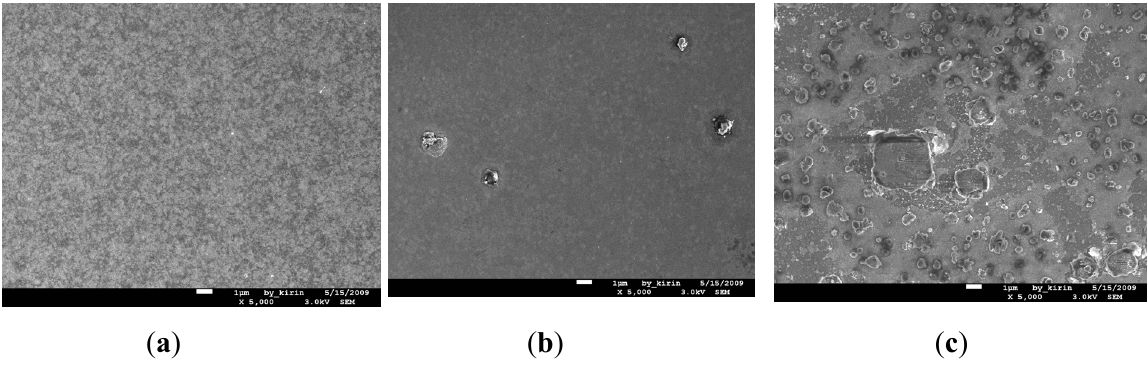
Figure 9. X-ray diffraction patterns for the structures of MgO (2 nm) sample annealed for 5 min at temperatures from room temperature to 800 °C.